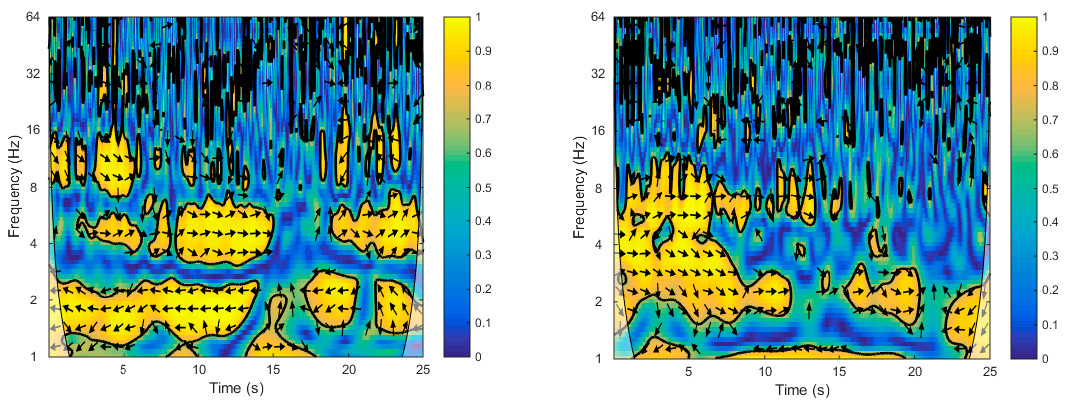
Figure 10. Wavelet coherence between the main span’s signals and the side span’s signals: ( a ) vertical acceleration signals (Set 1); ( b ) transverse acceleration signals (Set 2). The arrows represent the relative phase relationship, where a right-pointing arrow represents in-phase and a left-pointing arrow represents anti-phase.